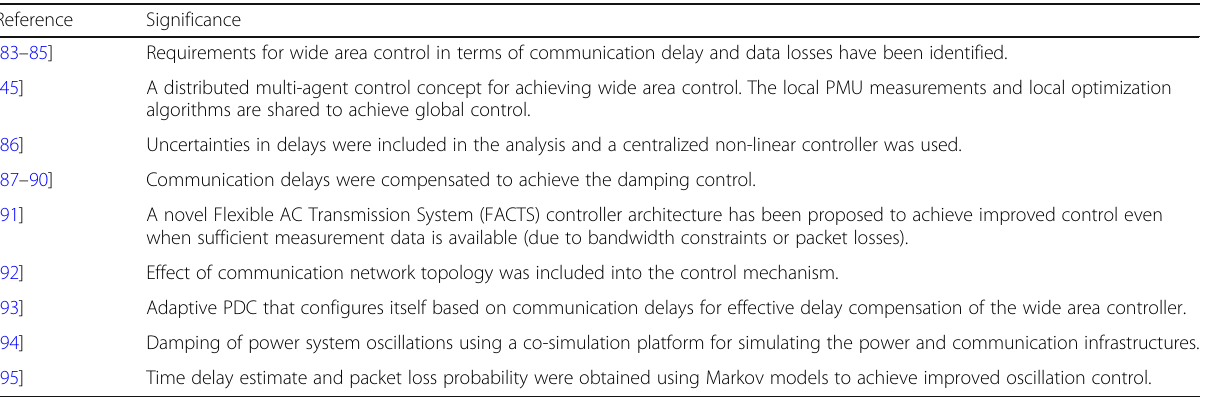
Table 6 Wide Area Damping Controllers